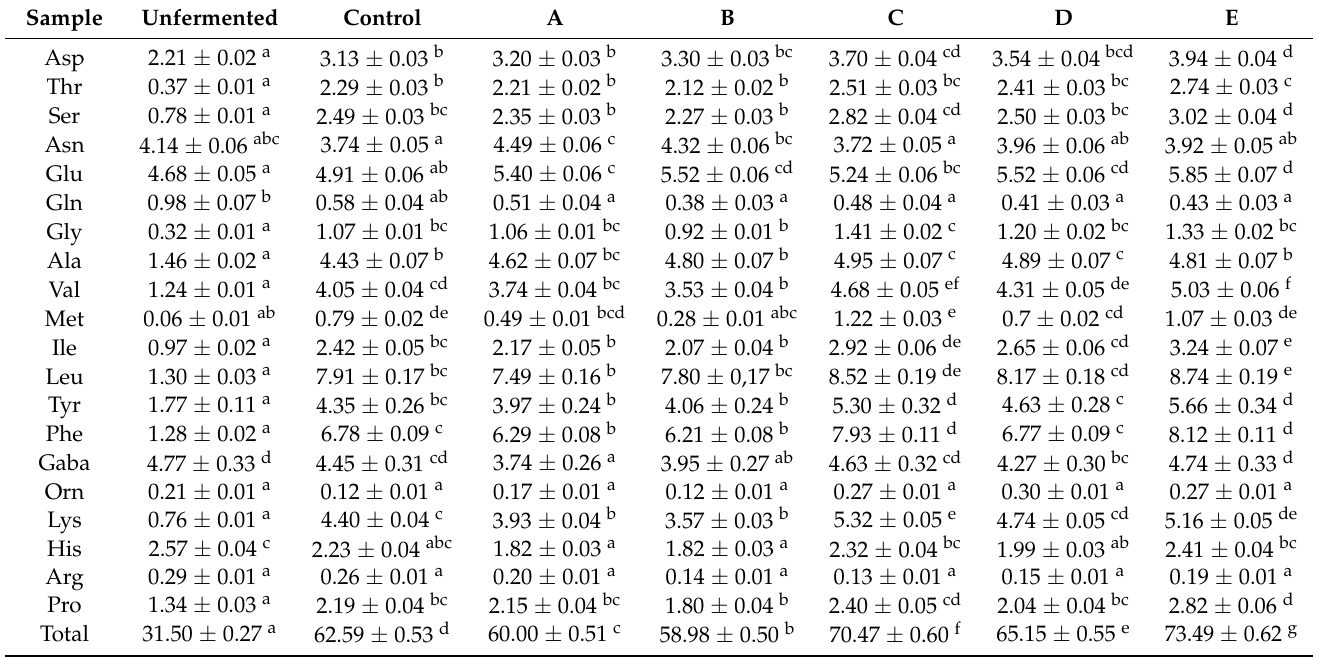
Figure 4. Chromatographic profiles (detection at 570 nm) of the unfermented cocoa (purple) and fermented (six days) control (green). Table 2. Free amino acids in fermented (six days) cocoa beans in comparison with unfermented cocoa and spontaneously fermented cocoa (control), expressed as mg/g of the total protein content.